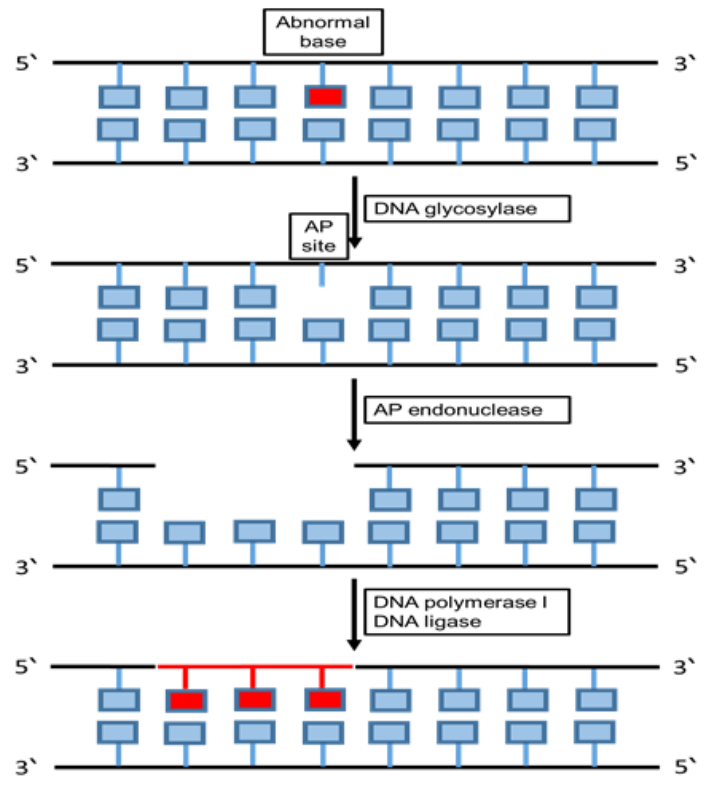
Figure 3. Base excision repair pathway. The schematic diagram summarizes the main components and the mechanism of the base excision repair (BER) pathway. This repairing pathway removes and replaces the faulty DNA segment with a new segment through allowing the cells to eliminate part of a damaged DNA strand and substitute it through DNA synthesis using the undamaged strand as a